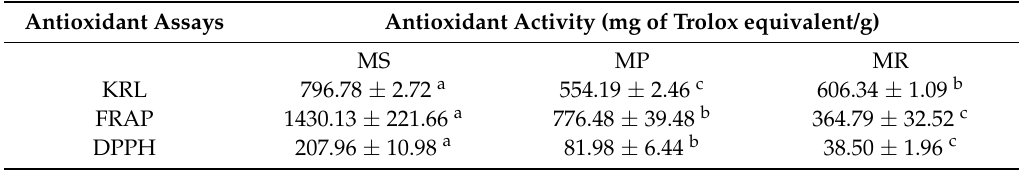
Table 2. Antioxidant activity of ethanolic mint extracts using the Kit Radicaux Libres (KRL TM ), the ferric reducing antioxidant power (FRAP) and the 2,2-diphenyl-1-picrylhydrazyl (DPPH)